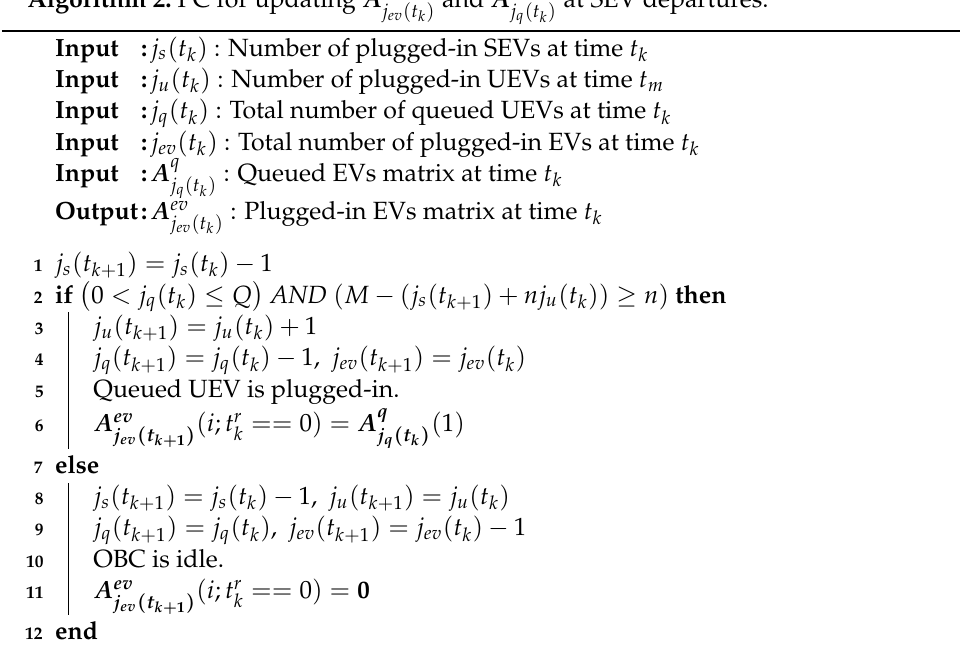
Algorithm 2: PC for updating A ev